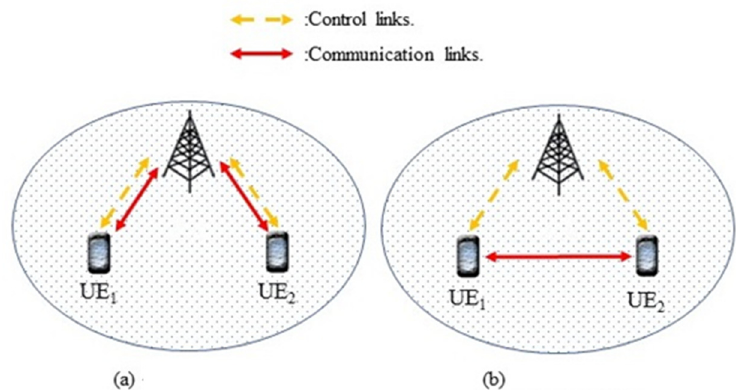
Figure 2. An illustration for cellular and D2D communication. ( a ) Regular cellular communication. ( b ) LTE D2D communication.